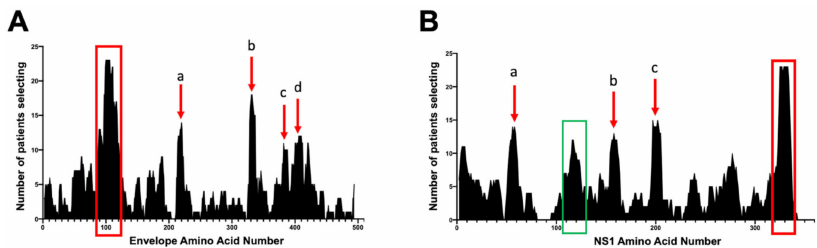
Figure 2. Comparison of 26 primary infected sera samples to determine population-wide antibody responses. Sequence analysis among the 26 serum samples were then combined to compare the number of study subjects selecting for specific regions at a pre-determined fold cuto ff ( > 100-fold enrichment compared to the starting library) of envelope (E) polypeptide ( A ), or non-structural protein 1 (NS1) polypeptide ( B ). Red boxes represent regions selected by more than 75% of the serum samples. Arrows indicate other regions that were selected by ~50% of the study subjects. ( A ) E protein in domain II (arrow a), domain III (arrow b and c), and the juxtamembrane stem region (arrow d). ( B ) NS1 56–71 arrow a, 154–170 arrow b, and 193–204 arrow c. The green box indicates the previously described wing domain